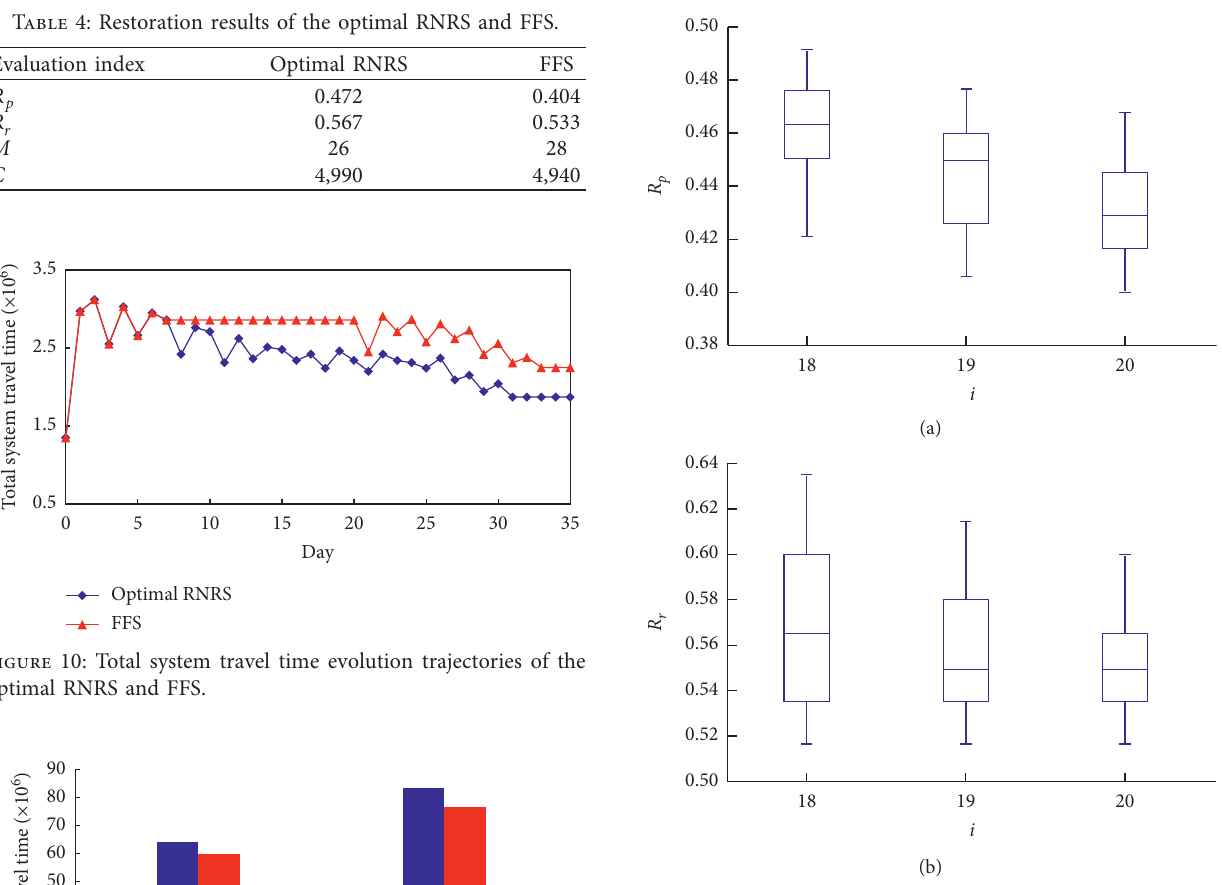
Figure 12: Box plot for (a) R